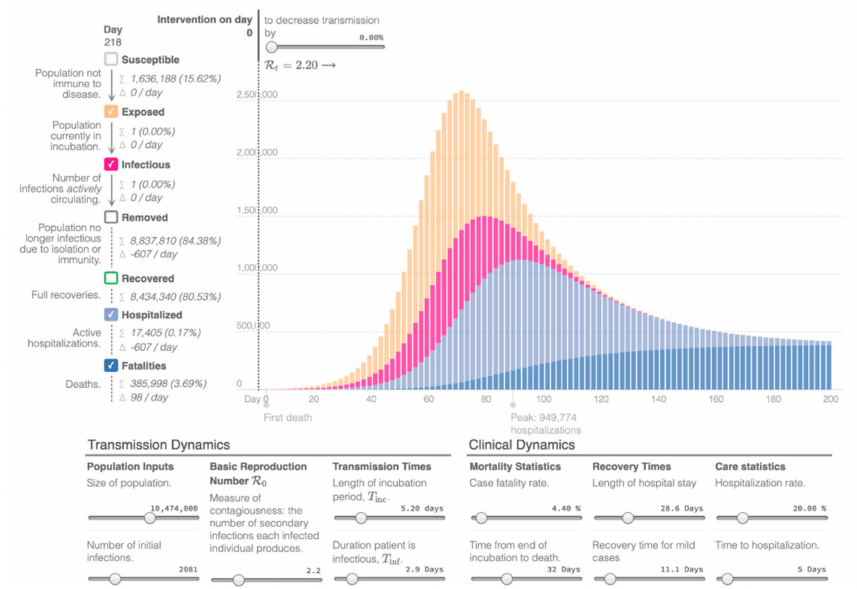
Figure 1. Epidemiological Curve